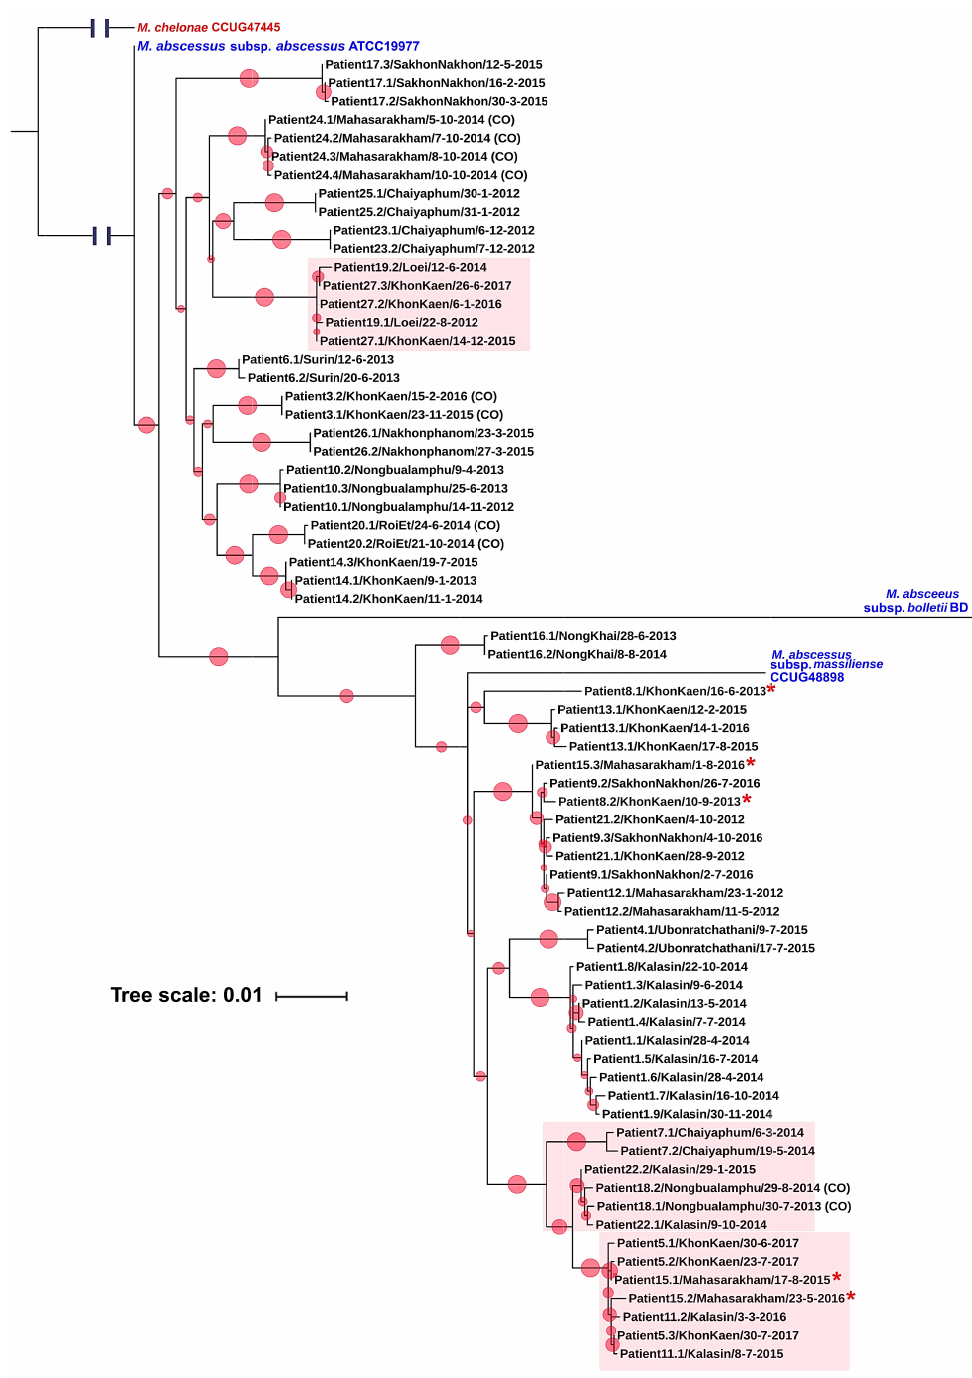
Figure 1. Phylogenetic tree of 69 isolates of M. abscessus causing persistent infection or re-infection based on 1230 high-confidence SNPs from WGS analysis. Relationships between serial isolates as depicted in this tree were the basis for distinguishing between persistent infection (PI) and re- infection (RI). The phylogeny was inferred using the maximum likelihood method with 1000 bootstrap replicates. Each red circle represents a bootstrap value and the size of the circle is proportional to its value (the largest circles represent 100%). Reference strains of each M. abscessus subspecies were included. Mycobacterium chelonae CCUG47445 was used as the outgroup. Red boxes enclose four clusters of possible transmission events. Red asterisks indicate the re-infection of Patient #8 and Patient #15. “CO” in brackets refers to instances of